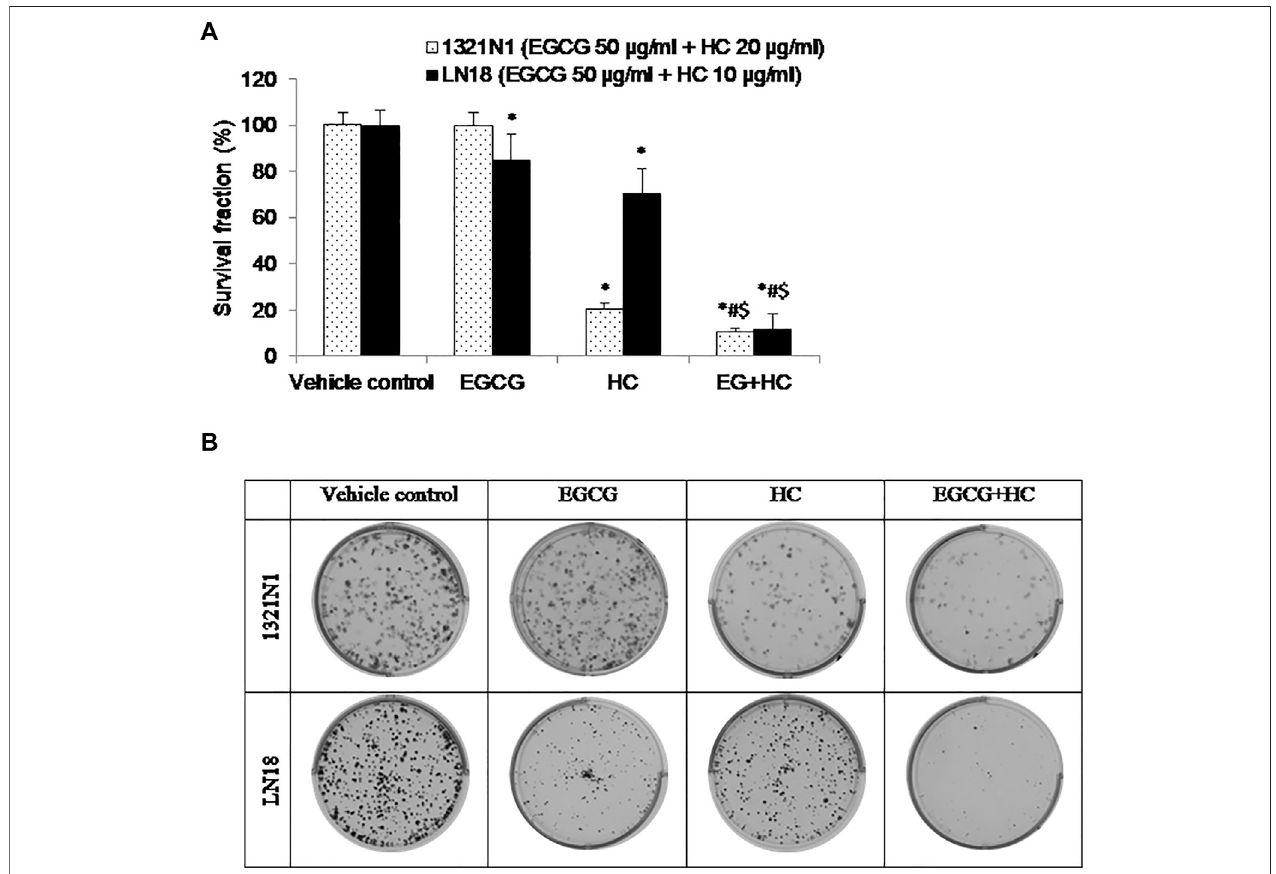
FIGURE 9 | (A) The bar graph depicts the suppression of glioma cell colony formation by EGCG, HC, and EGCG+HC in 1321N1 and LN18 cells. (B) 1321N1 and LN18 cell colonies treated with EGCG, HC, and EGCG+HC. Each bar re fl ects the mean±SD determined from three independent experiments. * p < 0.05 compare to control, # p < 0.05 compare to EGCG, $ p < 0.05 compare to HC.